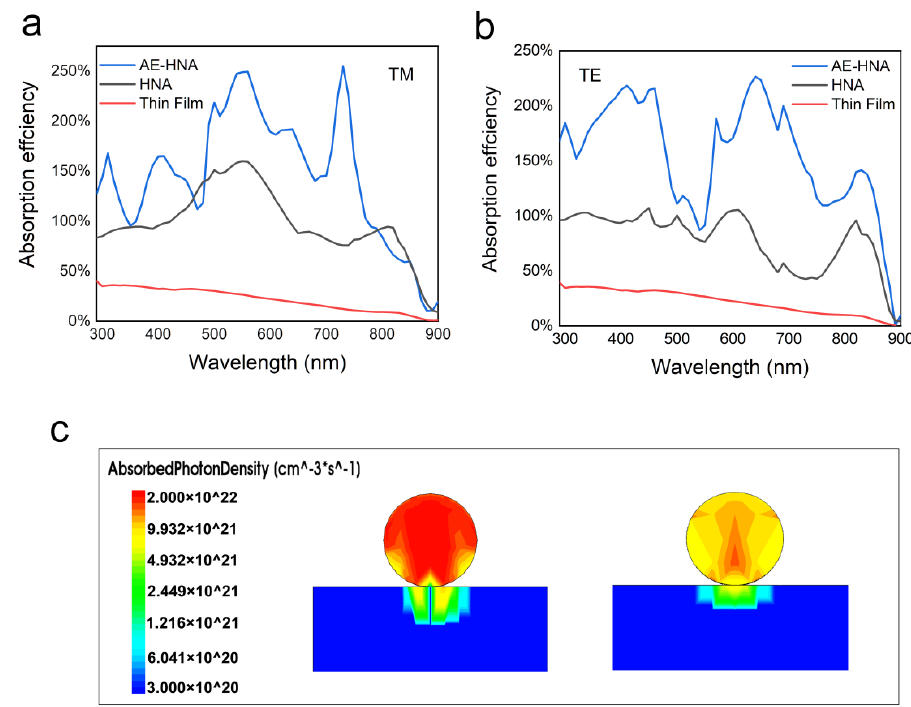
Figure 6. ( a , b ) The absorptance of the AE-HNA, HNA, and thin-film structures for TM and TE polarized light, respectively. ( c ) Comparison of the cross-sectional optical generation profiles of the AE-HNA and HNA structures.